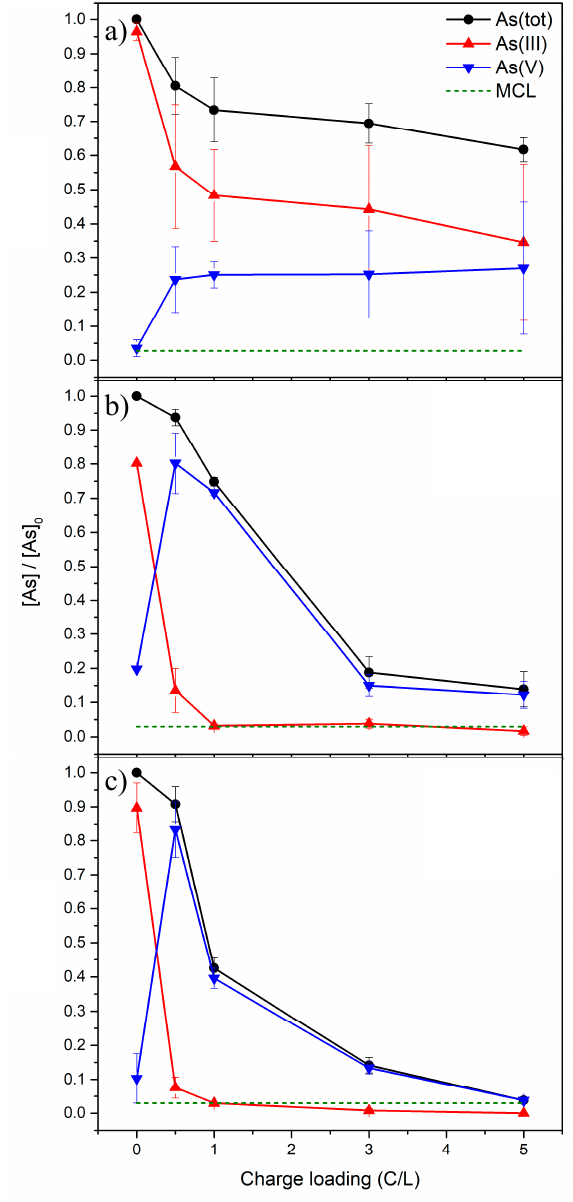
Figure 2. Speciation of arsenic during ( a ) electrocoagulation, ( b ) electrochemical peroxidation, ( c ) photo-assisted electrochemical peroxidation: ( • ) As total , ( (cid:78) ) As(III), ( (cid:72) ) As(V). Dashed line indicates the maximum contaminant level of 10 µ g / L recommended by the World Health Organization .